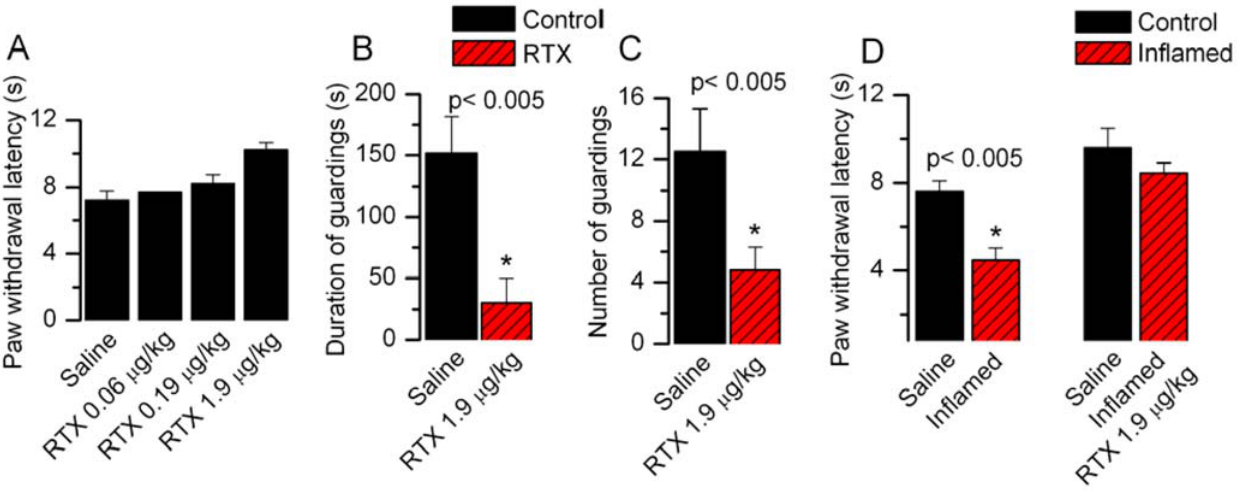
Figure 4. Intrathecal administration of RTX reduced pain behavior induced by capsaicin and inflammation. A . Effect of increasing concentrations of RTX on PWL to radiant heat. B, C . nThe duration and the number of nocifensive behaviors after intraplantar capsaicin significantly decreased after RTX treatment D . PWL to a thermal stimulus after injection of carrageenan is significantly reduced as compared to saline injected animals.